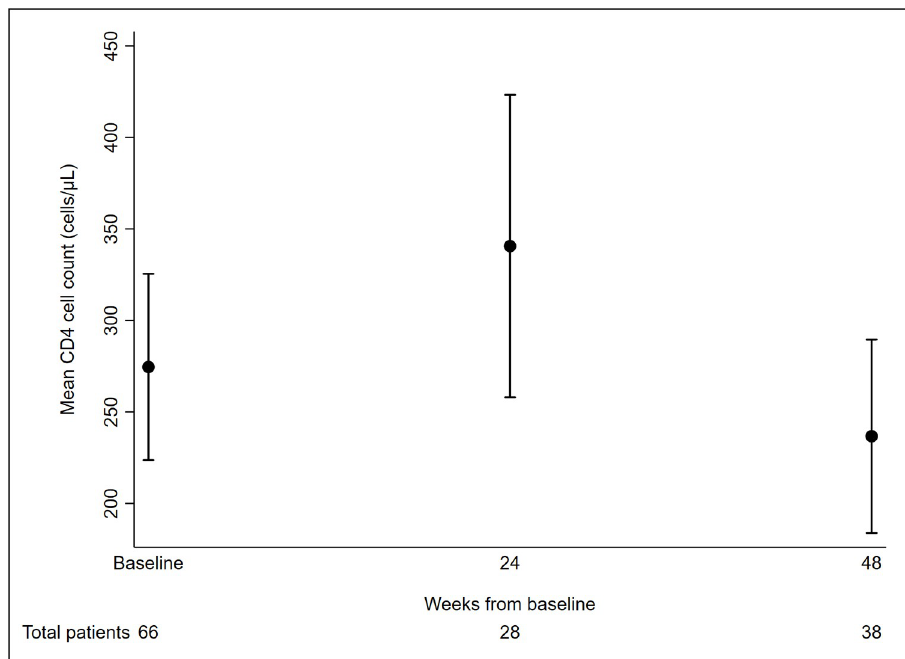
Fig 2. Changes in the mean CD4 cell counts in patients with holding